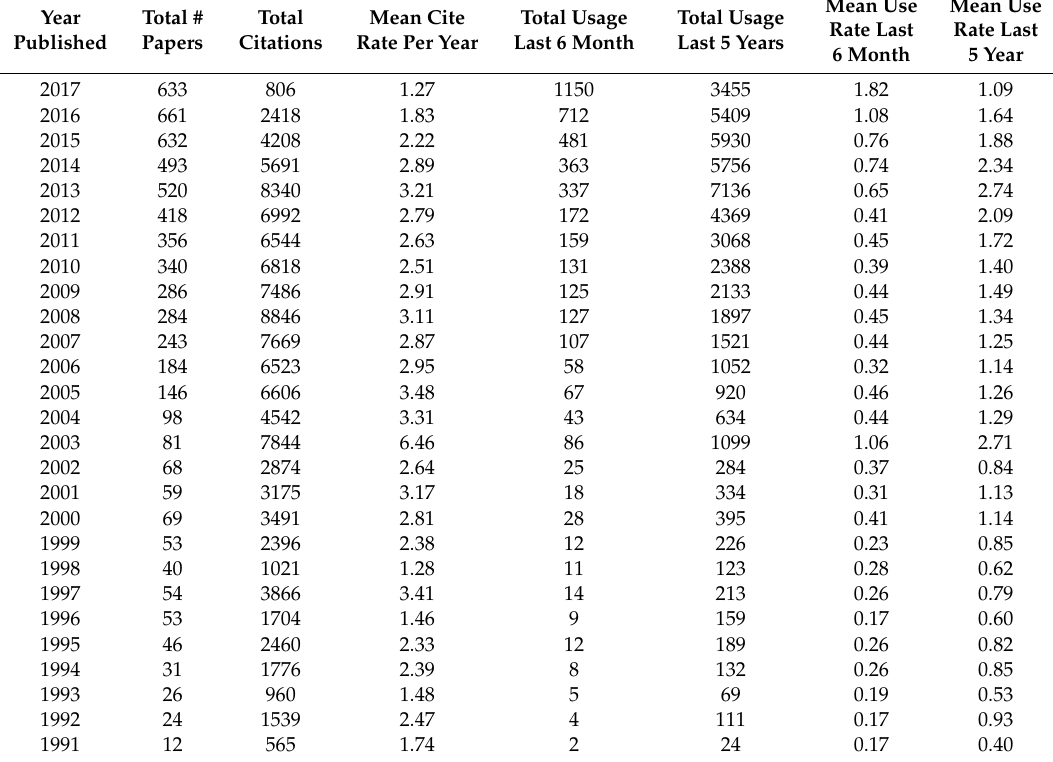
Table 3. General characteristics of